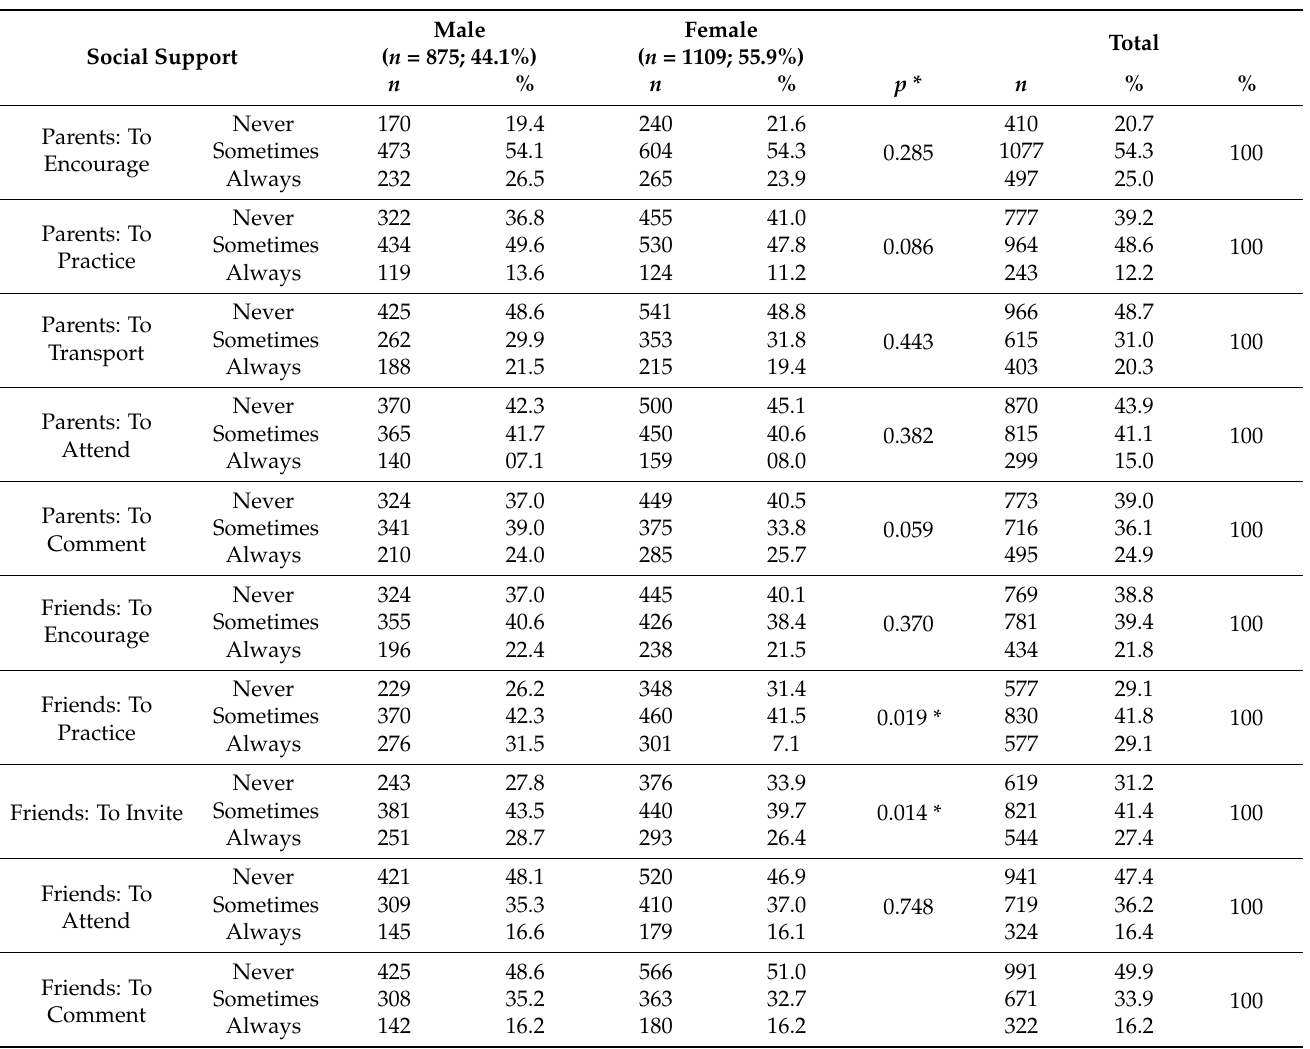
Table 2. Social support (parents and friends) for the practice of physical activity according to gender ( N =